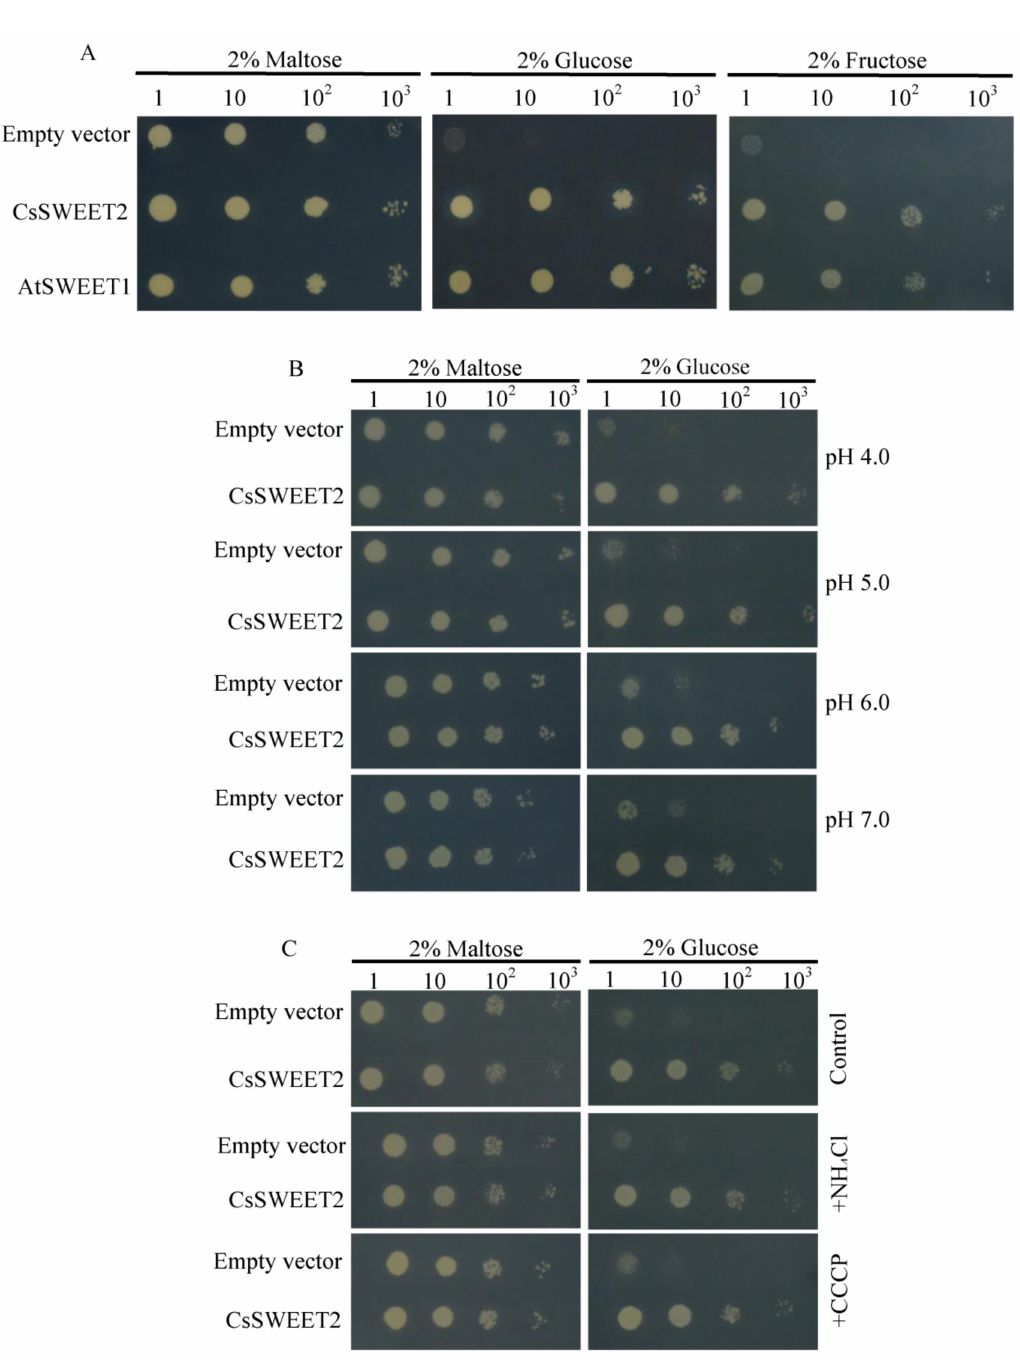
Figure 4. Sugar transport activities of CsSWEET2 expressed in the yeast mutant EBY.VM4000. ( A ) CsSWEET2 and AtSWEET1 complemented the glucose and fructose uptake deficiency of EBY.VM4000, but the empty vector did not. ( B ) Functional complementation of the glucose up- take deficiency of EBY.VM4000 by CsSWEET2 at different pHs. ( C ) Effects of metabolic inhibitors on yeast growth.Yeast cells expressing an empty vector or a vector containing CsSWEET2 or AtSWEET1 were serially diluted (10-fold) and cultured on selective synthetic deficient media without uracil (SD-Ura) supplemented with 2% ( w/v ) maltose, 2% ( w/v ) glucose, or 2% ( w/v ) fructose as the sole car- bon source. Images were captured after incubation at 30 ◦ C for 3 days. An empty vector (pDRf1-GW) was used as a negative control. AtSWEET1 , which has been shown to mediate glucose and fructose uptake in the yeast EBY.VM4000 mutant [25], was used as a positive control. CCCP, carbonyl cyanide m-chlorophenyl